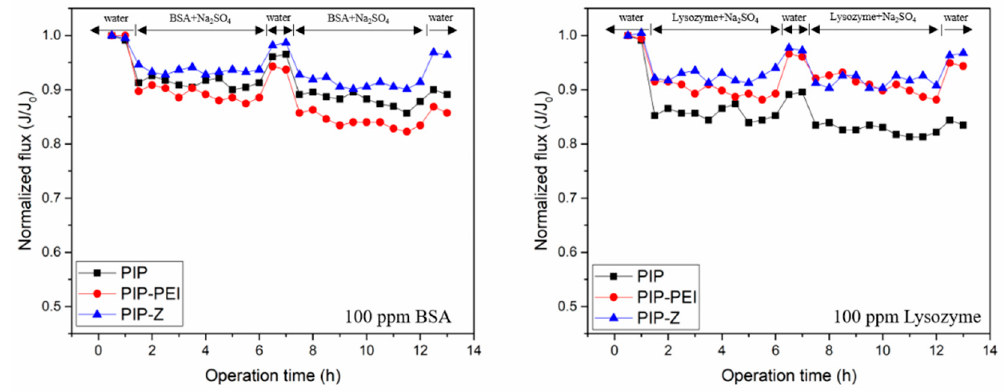
Figure 8. Dynamic fouling experiments with 100 ppm BSA and 100 ppm lysozyme. The pressure was maintained at 6 bar during fouling test.